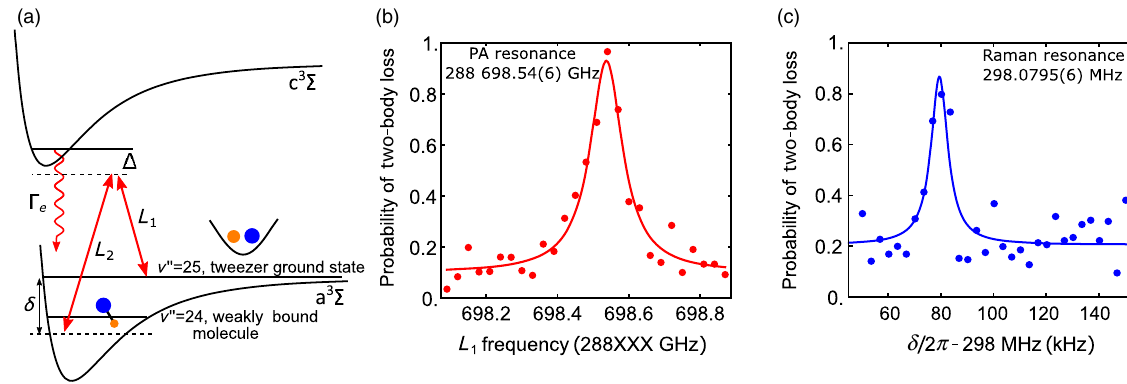
FIG. 4. (a) Level diagram for two-photon Raman transfer from an atom pair to a weakly bound molecule. Two lasers L 1 and L 2 with a frequency difference δ derived from an acousto-optic modulator (AOM) are phase coherent and drive the atoms from the tweezer motional ground state ( v 00 ¼ 25 ) to the weakly bound molecular state a 3 Σ þ ( v 00 ¼ 24 or v 00 ¼ − 1 ). A large detuning Δ from the excited state c 3 Σ ð v 0 ¼ 0 Þ , which decays at a rate Γ e , reduces spontaneous emission during molecular transfer, which occurs when the two-photon frequency difference δ is resonant with the binding energy. (b) Photoassociation spectroscopy of the intermediate excited state. With the laser L 2 off, the L 1 laser drives the atoms to the excited molecular vibrational states when resonant. The Na þ Cs two-body loss probability is measured as a function of the PA frequency for a 75-ms pulse duration. The c 3 Σ þ 1 ð v 0 ¼ 0 ; J 0 ¼ 2 ; F 0 ¼ 7 Þ state is observed at 288 698.64(6) GHz. (c) Two-photon Raman resonance for transferring single atoms to a molecule. With a detuning Δ ¼ 2 π × 3 . 2 GHz, the frequency difference δ of the L 1 and L 2 beams is scanned around the binding energy of the a 3 Σ þ ð v 00 ¼ 24 Þ state. The Raman resonance is observed at 298.0795(6) MHz with a FWHM of 8(2) kHz, indicating transfer of the atom pair to the weakly bound molecular